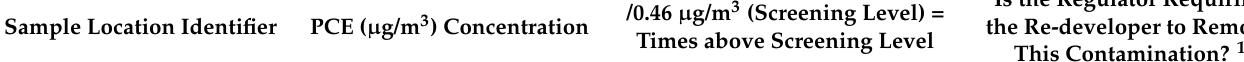
Table 1. Onsite Soil-Gas Perchloroethylene (PCE): Up to 5 Orders of Magnitude above the Health-Protective, Environmental Screening Levels (ESLs)